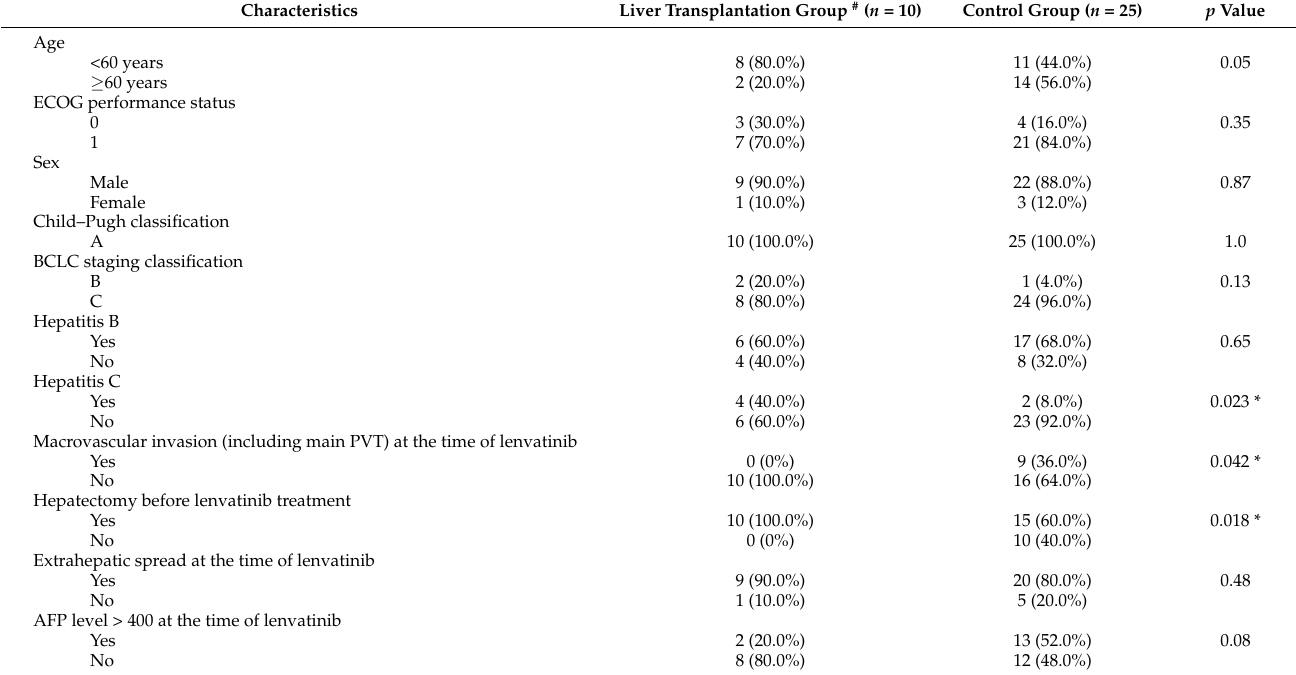
Table 2. Clinicopathological parameters in 35 patients with unresectable hepatocellular carcinoma who received lenvatinib.